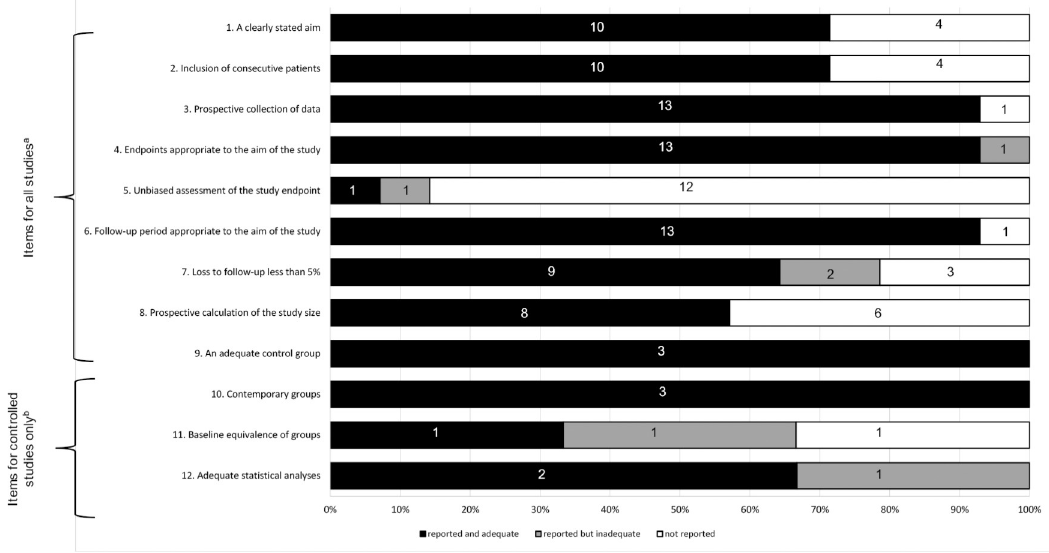
Fig 2. Quality assessment of the studies included in the systematic review based on Methodological Index for Nonrandomized Studies (Slim et al, 2003) [15]. (A) Quality items for all observational studies. (B) Quality items for comparative studies.